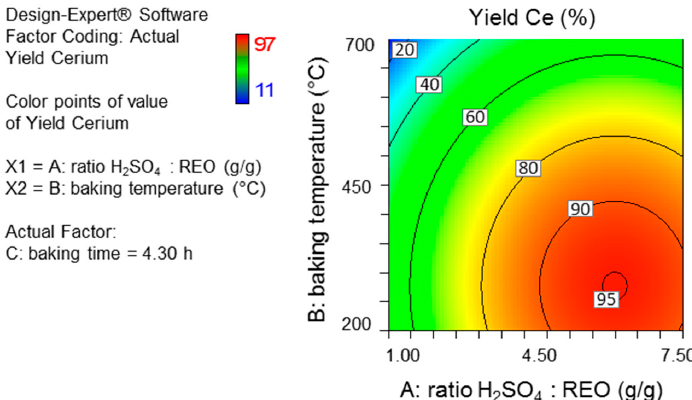
Figure 10. Contour diagram for the response “Yield Ce” for the combined effects ratio of H 2 SO 4 to REO and baking temperature. The baking time was set to 4.3 h.